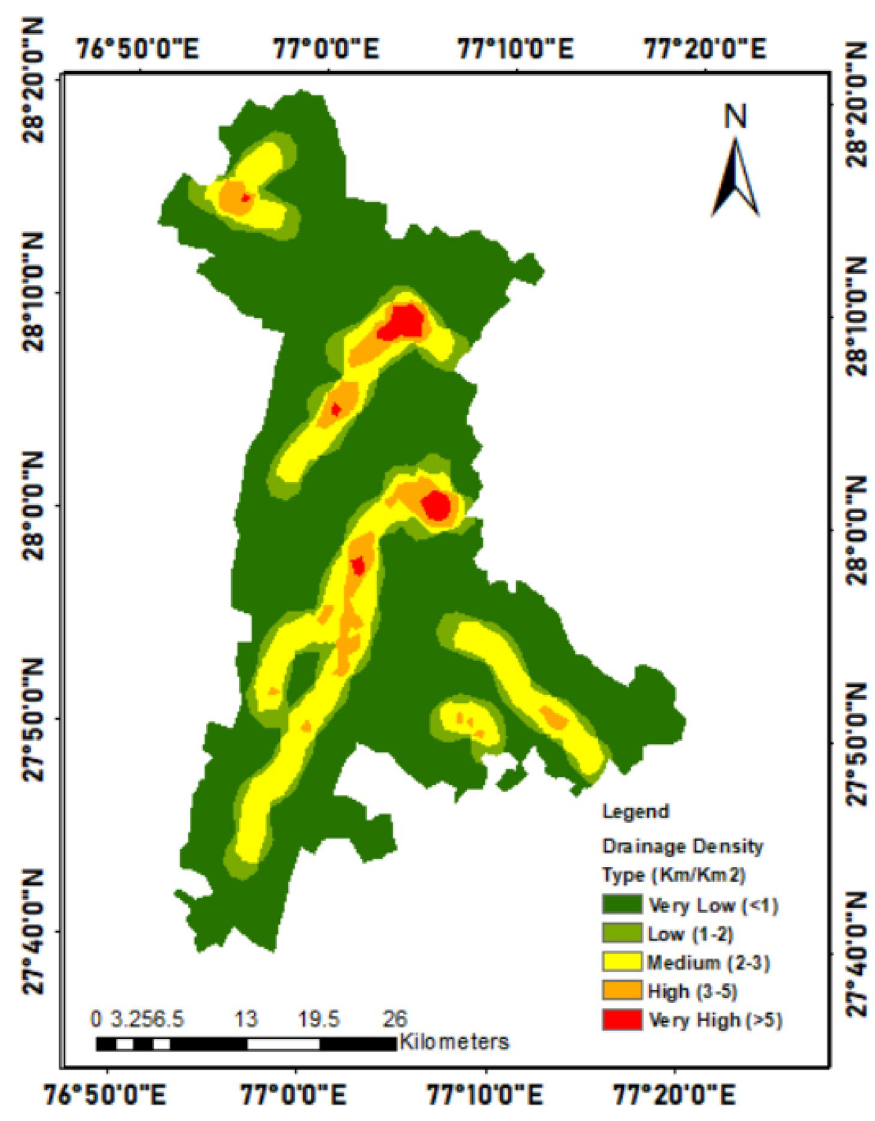
Fig. 2 Drainage density map of study